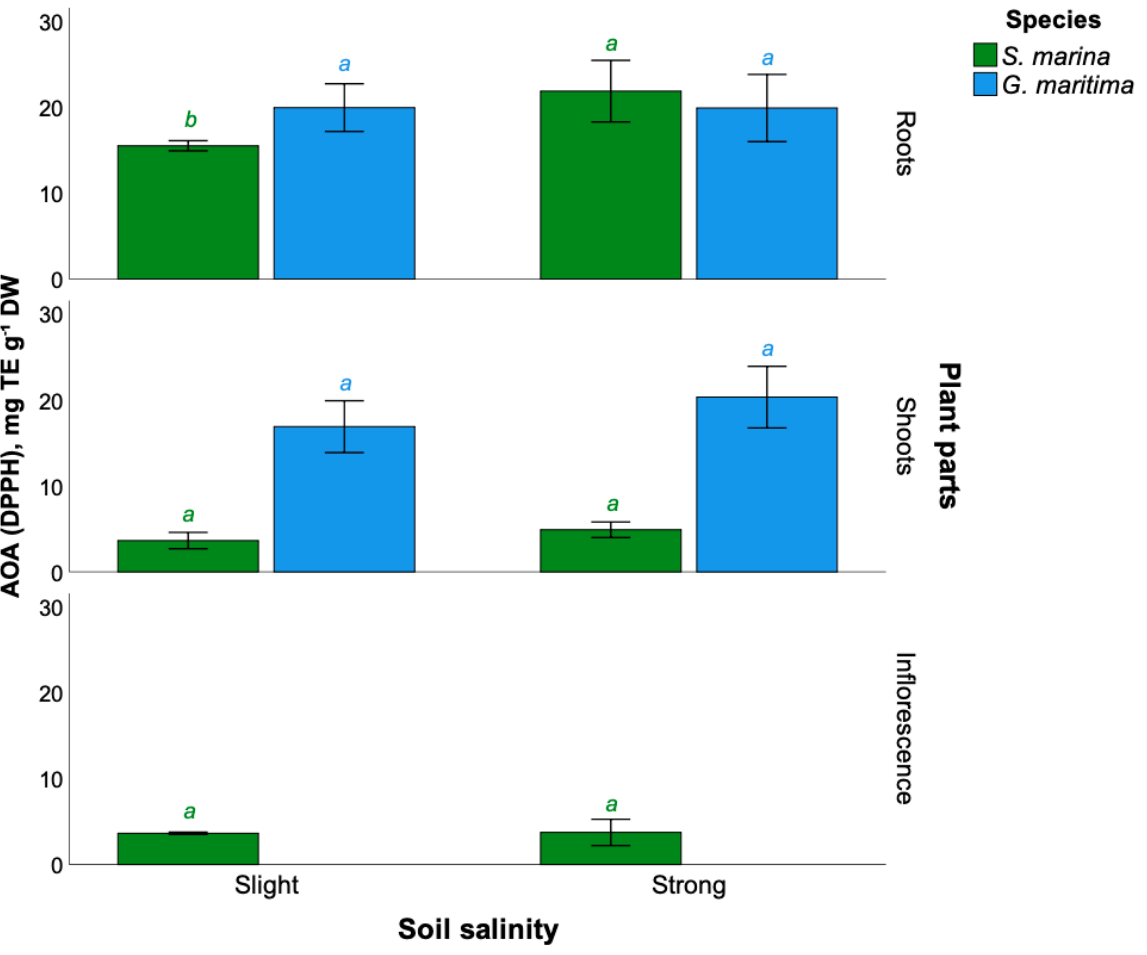
Figure 4. Antioxidant activity (DPPH) of extracts from different parts of the studied plants of S. marina and G. maritima at different levels of soil salinization. Different letters indicate significant differences among the different levels of soil salinity ( t -test, p ≤ 0.05).